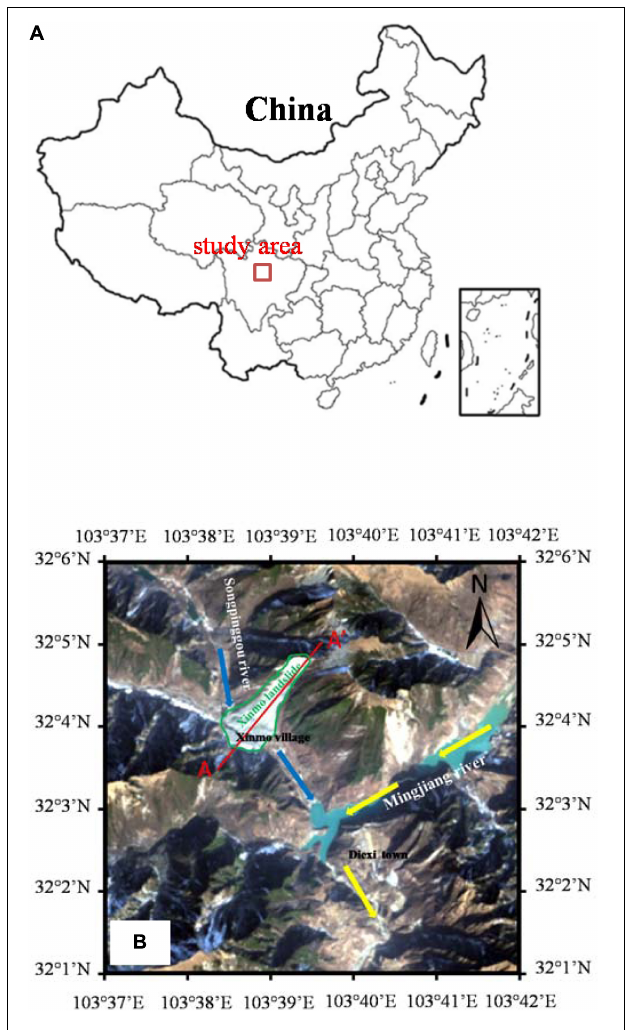
FIGURE 1 | Location of the 2017 Xinmo Landslide: (A) map of China and regional location of the study area. The small inset box in the lower right corner of the map of China is the South China Sea. (B) Landsat-8 image of the study area acquired on Jan. 19, 2018.